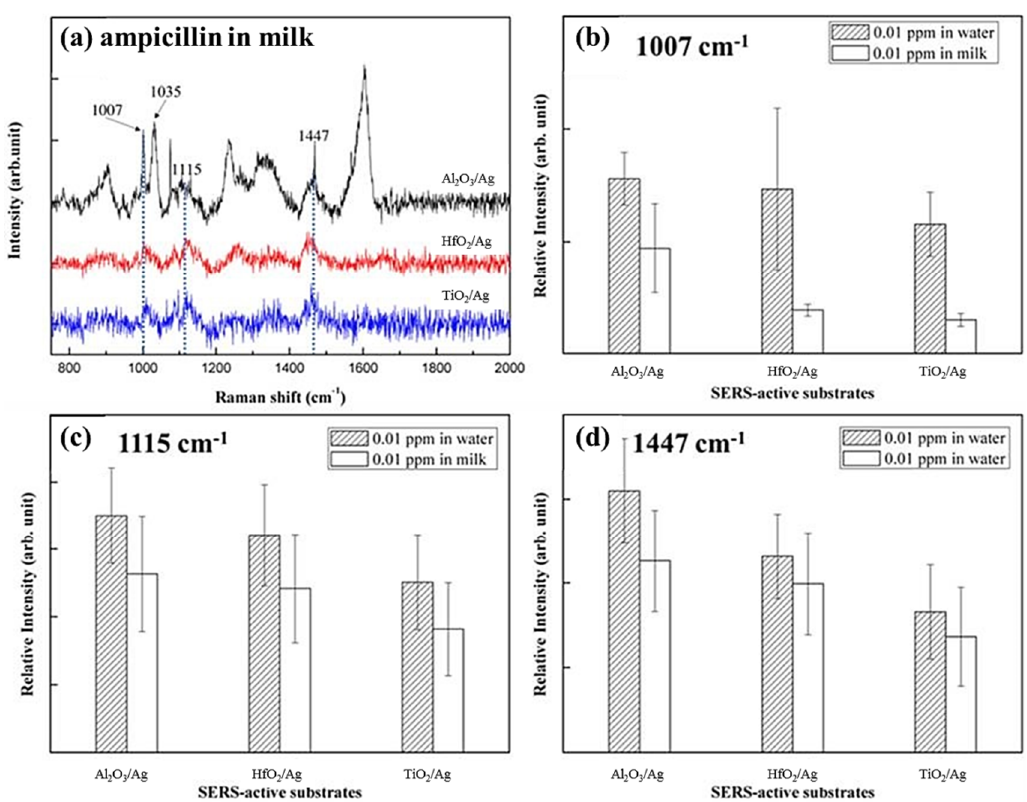
Figure 6. SERS spectra of ampicillin in milk with a concentration of 0.01 ppm upon ( a ) HfO 2 /, Al 2 O 3 /, and TiO 2 /Ag HNS were shown. By taking different characteristic peaks ( b ) 1007 cm −1 , ( c ) 1115 cm −1 , and ( d ) 1447 cm −1 in water or in milk solution, their relative intensities were respectively compared.